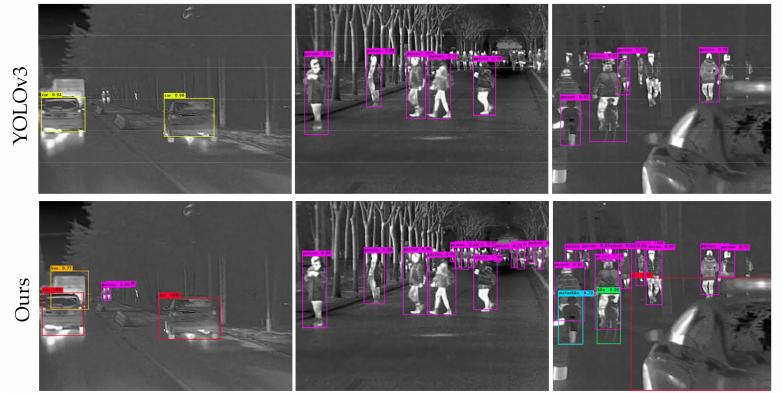
Figure 7. Qualitative results comparison between YOLOv3 detector and the improved detector. Both are using DarkNet-53 as the backbone.